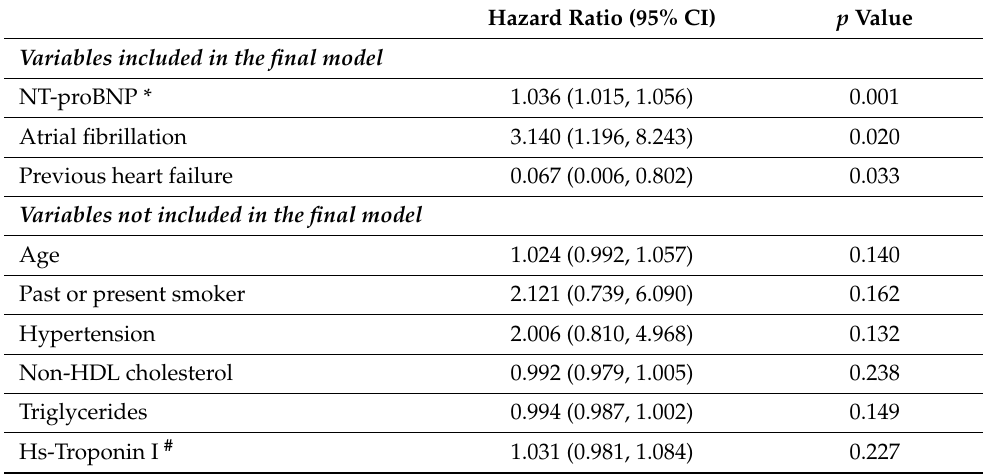
Table 4. Multivariate analysis showing the predictors of a cancer diagnosis before 3 years of